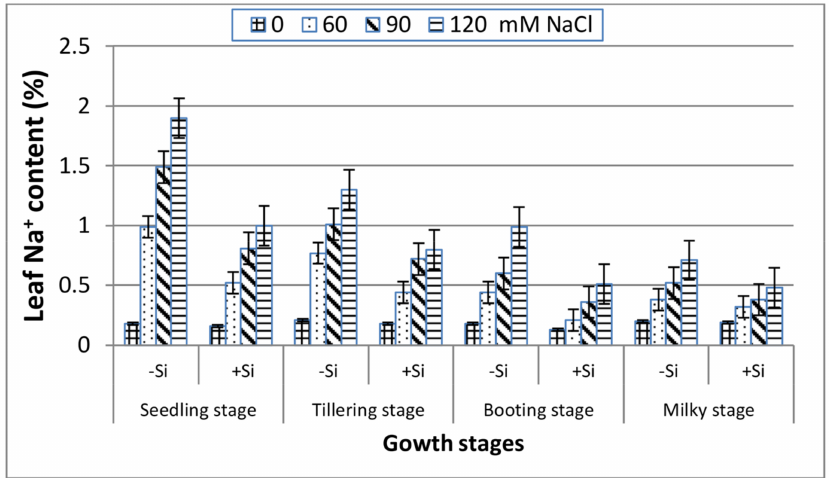
Figure 3. Effect of NaCl on the leaf Na + content of wheat at different growth stages in the presence and absence of